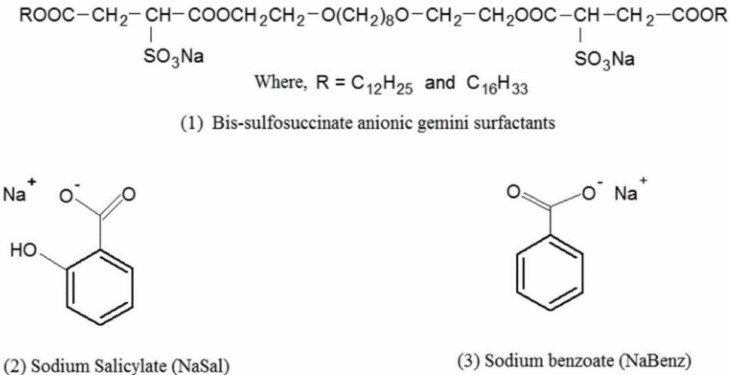
Figure 6. Molecular structures of (1) bis-sulfosuccinate anionic gemini surfactants, (2) sodium salicylate (NaSal), and (3) sodium benzoate (NaBenz). Adapted from [25].